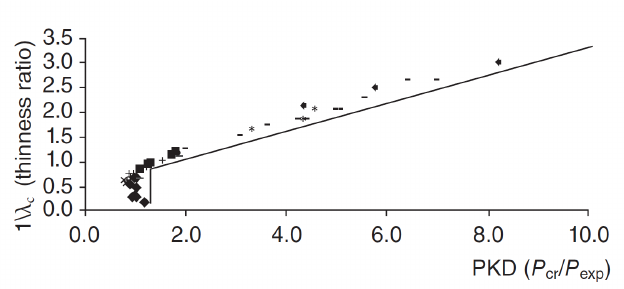
Figure 7. Design chart for the shell instability of machined circular cylinders